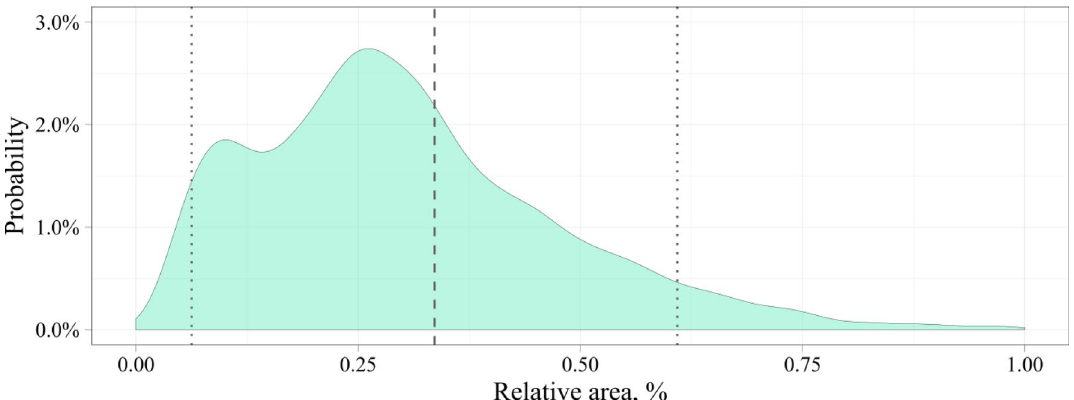
Figure 3. Distribution of the relative stenotic area in the input dataset.